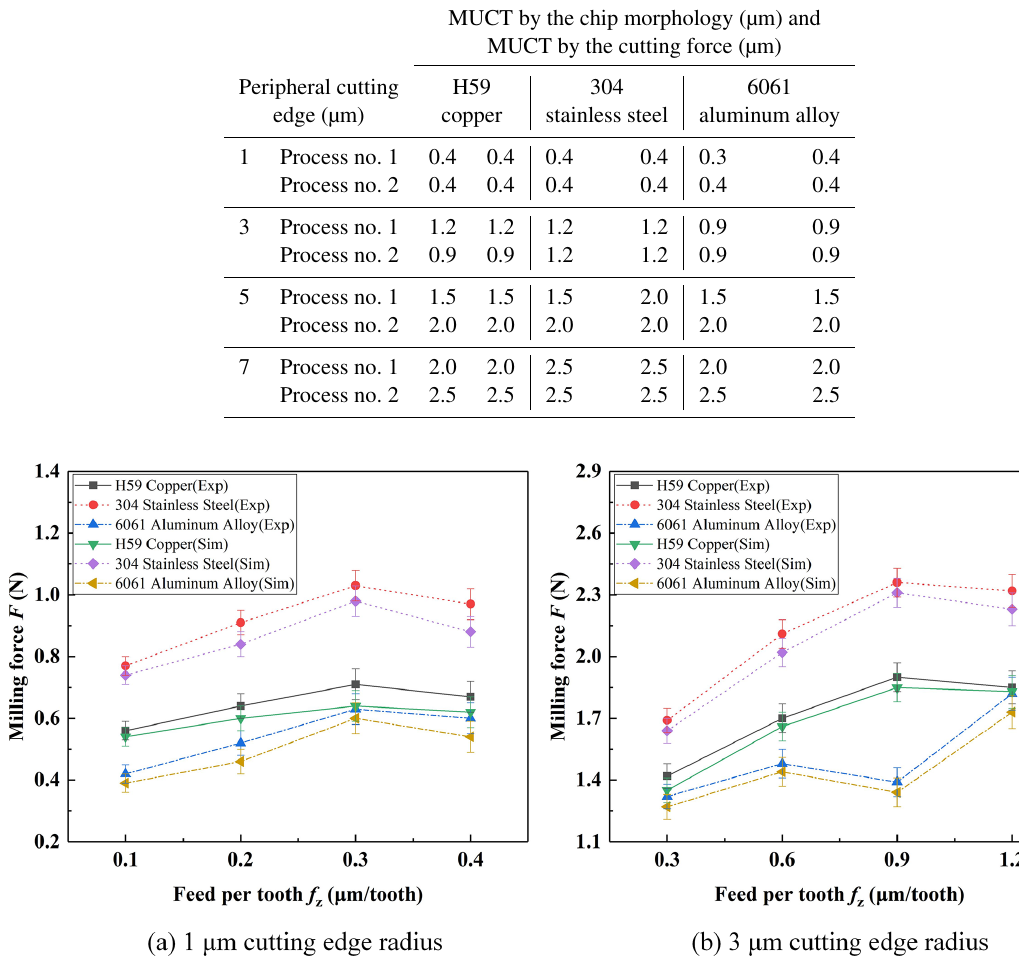
Table 5. MUCT-simulated results of the peripheral cutting edge.